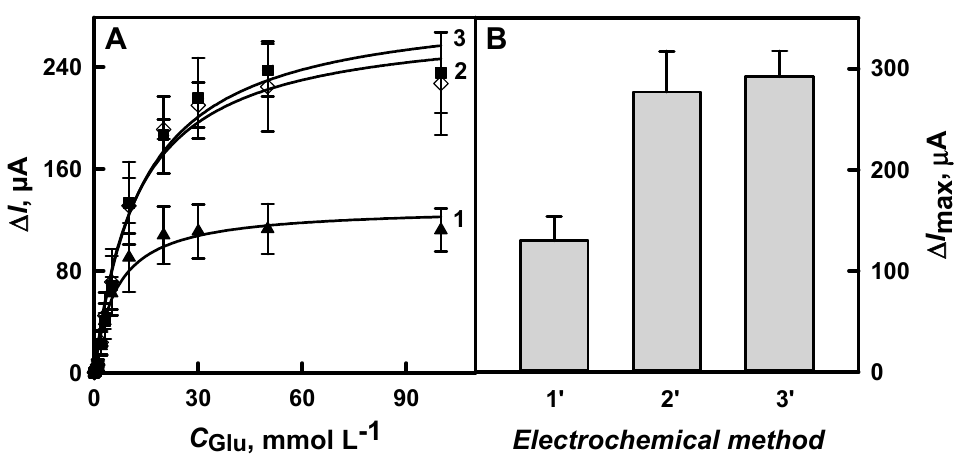
Figure 5 . Calibration plots ( A ) and diagrams ( B ) of glucose biosensors based on DGNs electrochemically deposited on the electrode using different electrochemical methods: 1, 1’—pulse amperometry; 2, 2’—differential pulse voltammetry; 3, 3’—constant potential amperometry. Synthesis of DGNs was performed in the solution of 6 mmol L − 1 HAuCl 4 with 0.1 mol L − 1 KNO 3 .